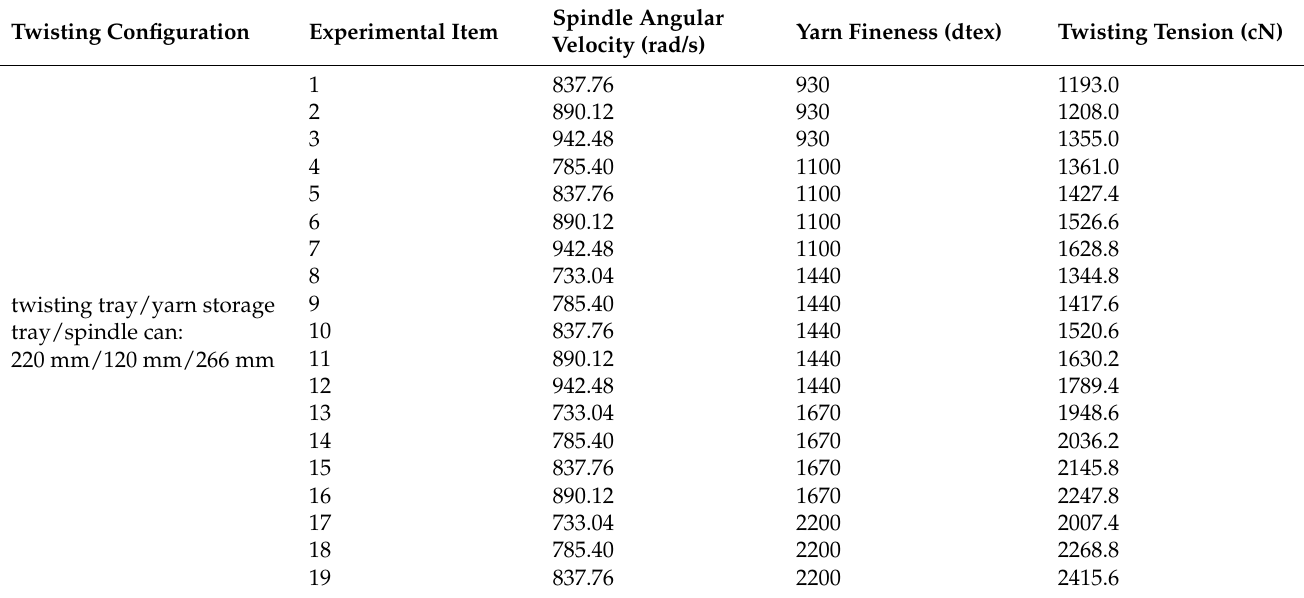
Table 3. Measurement values of twisting tension under different yarn fineness and spindle angu- lar velocity.